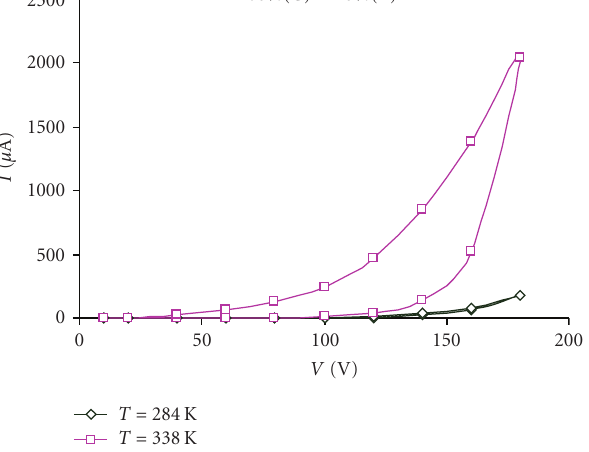
Figure 10: The hysteresis loop for sample no.3.